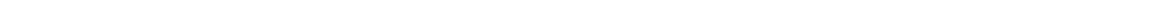
Figure 4 | HDAC1 is ubiquitinated in VC. ( a ) MG132 (10 m M, proteasome inhibitor) but not chloroquine (100 m M, lysosome inhibitor)